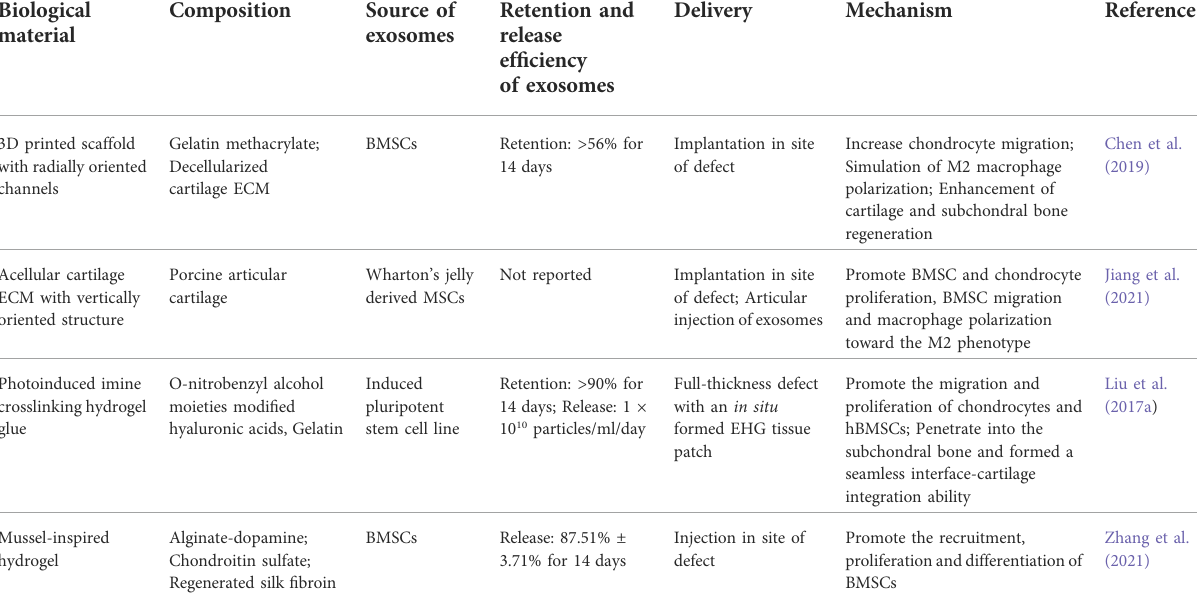
TABLE 3 Bioengineering materials combined with exosomes for repair and regeneration of